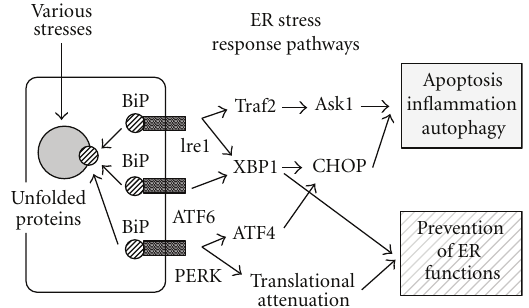
Figure 2: The major signal transduction pathway in the ER stress response. See the text for